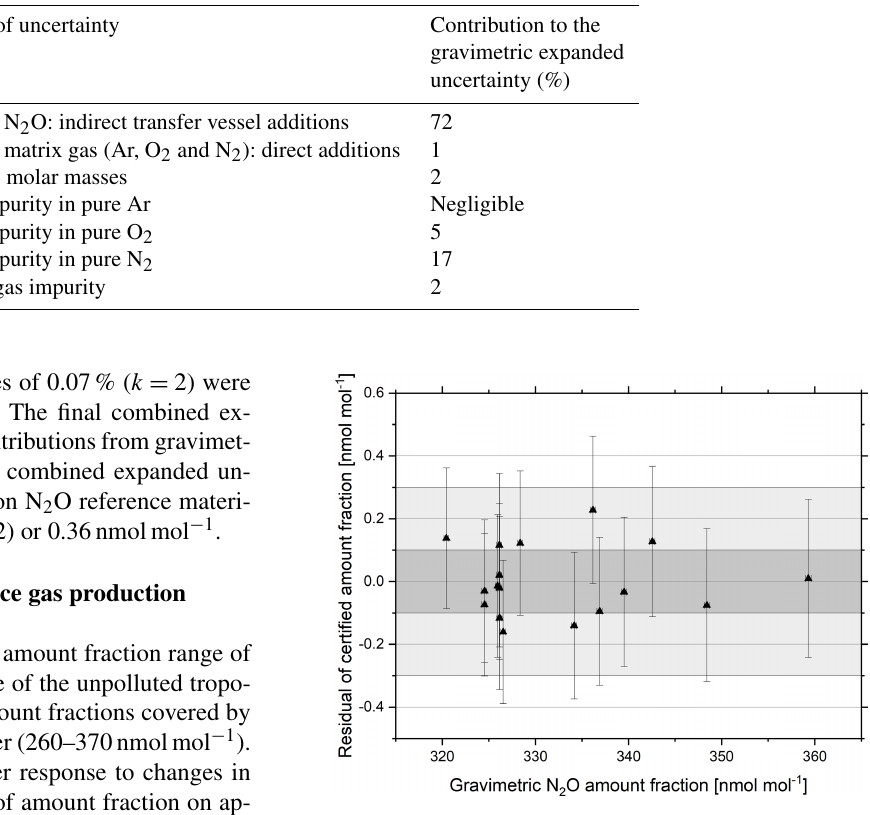
Figure 3. Residuals of the linear regression of the certified amount fraction as a function of the gravimetric amount frac- tion for N 2 O reference materials in the amount fraction range 320–360nmolmol − 1 certified against a 325nmolmol − 1 refer- ence material. The WMO-GAW Data Quality Objective (DQO) ( ± 0.1nmolmol − 1 ) is indicated within the dark grey shading, and the extended DQO ( ± 0.3nmolmol − 1 ) is indicated within the lighter grey shading. Error bars represent the combined ( k = 2) an- alytical ( y axis) and gravimetric ( x axis, not visible)